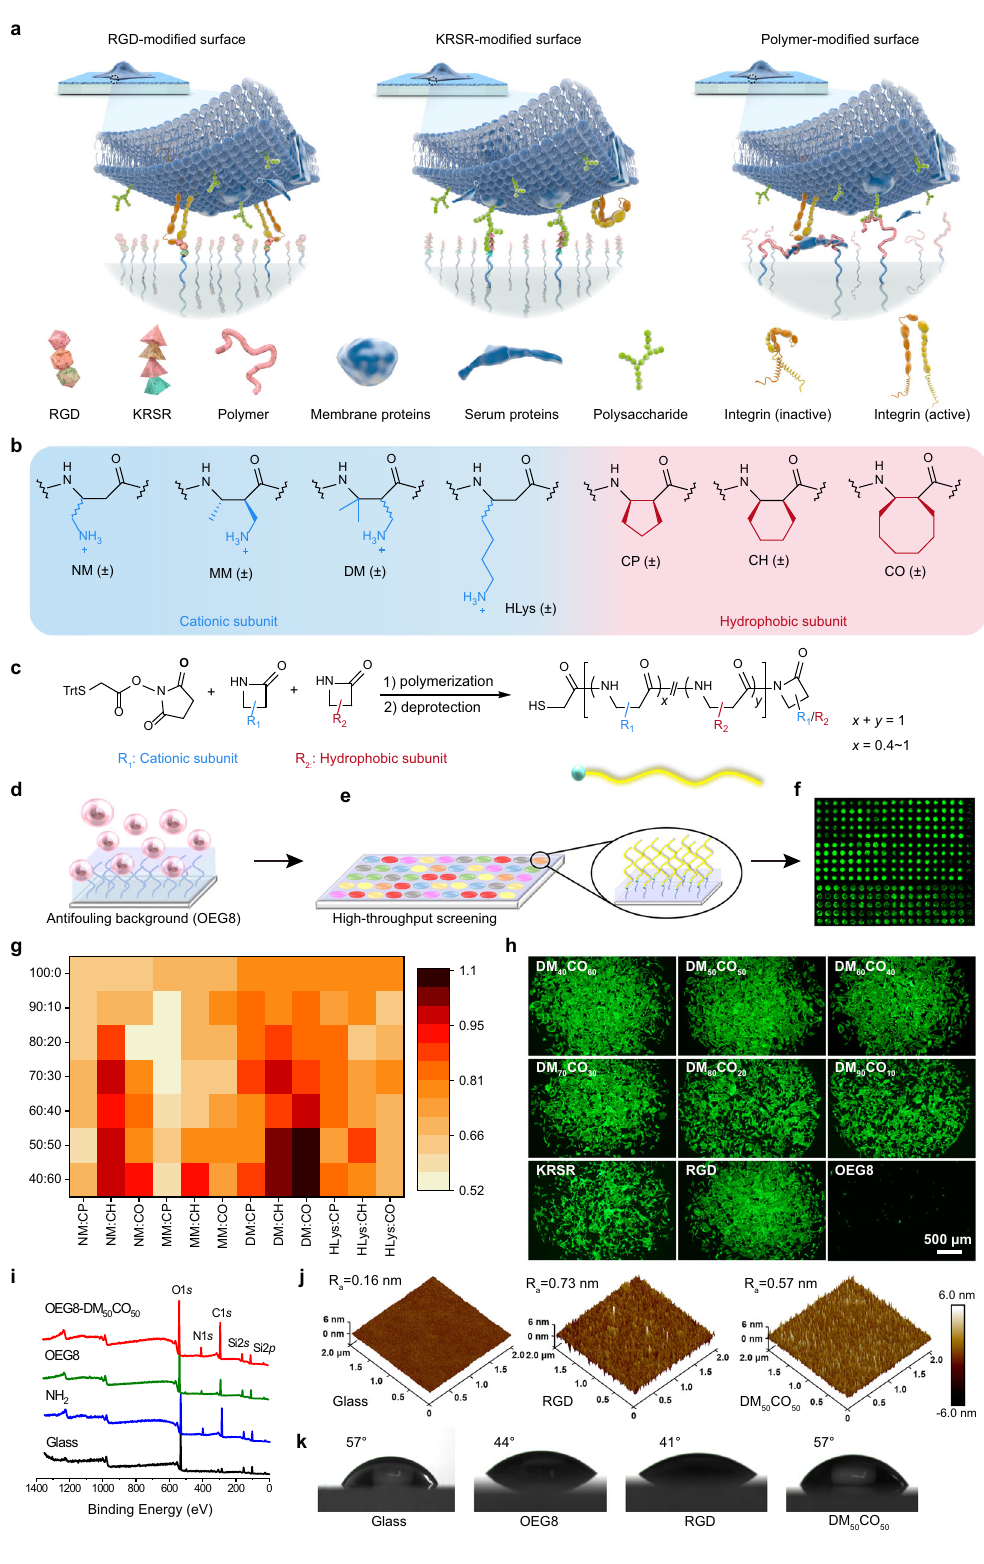
peptide-modi fi ed surfaces, fully spread and with many bundles of actin stress fi bers and extended focal adhesion, which is distinct from the narrow arrangement of actin micro fi laments and less spread cell morphology on KRSR-modi fi ed surfaces (Fig. 2b, c and Supplementary Fig. 5). The overall performance of DM 50 CO 50 implied a cell adhesion mechanism possibly